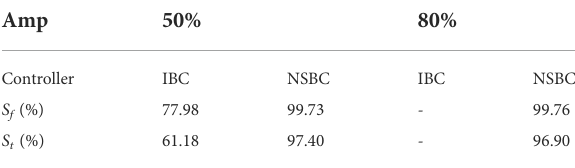
TABLE 3 Shake table control accuracies of IBC and NSBC in actual